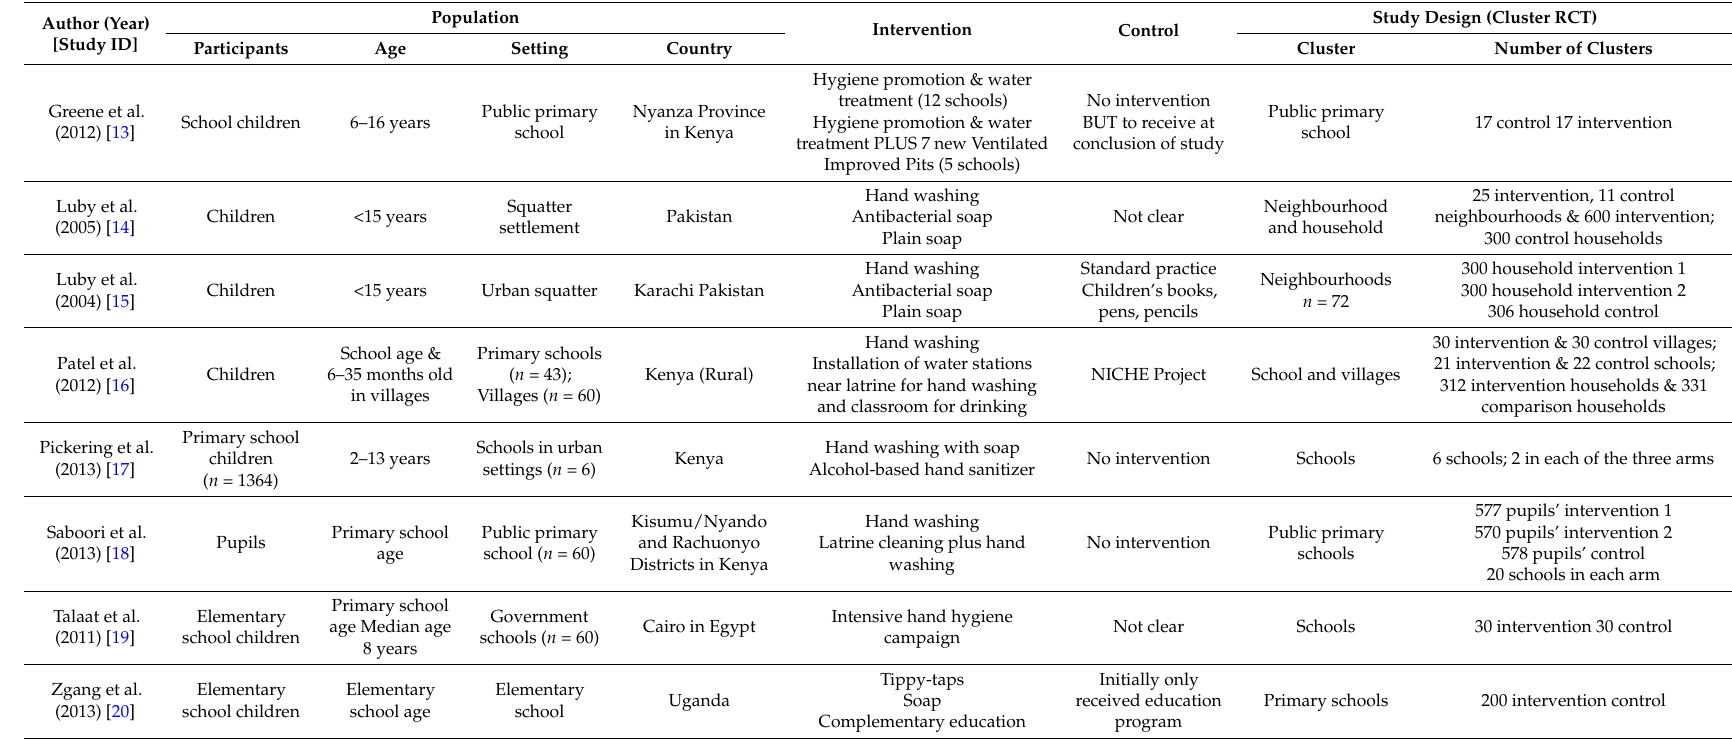
Table 1. Diagnostics of included